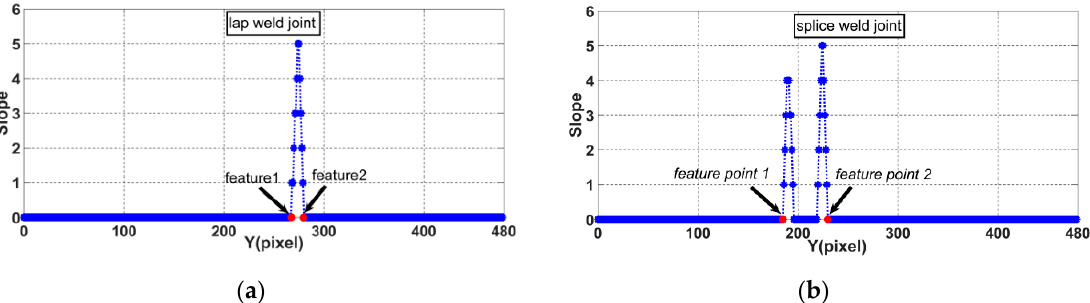
Figure 10. Final slope distribution along the laser curve: ( a ) lap weld joint and ( b ) splice weld joint.